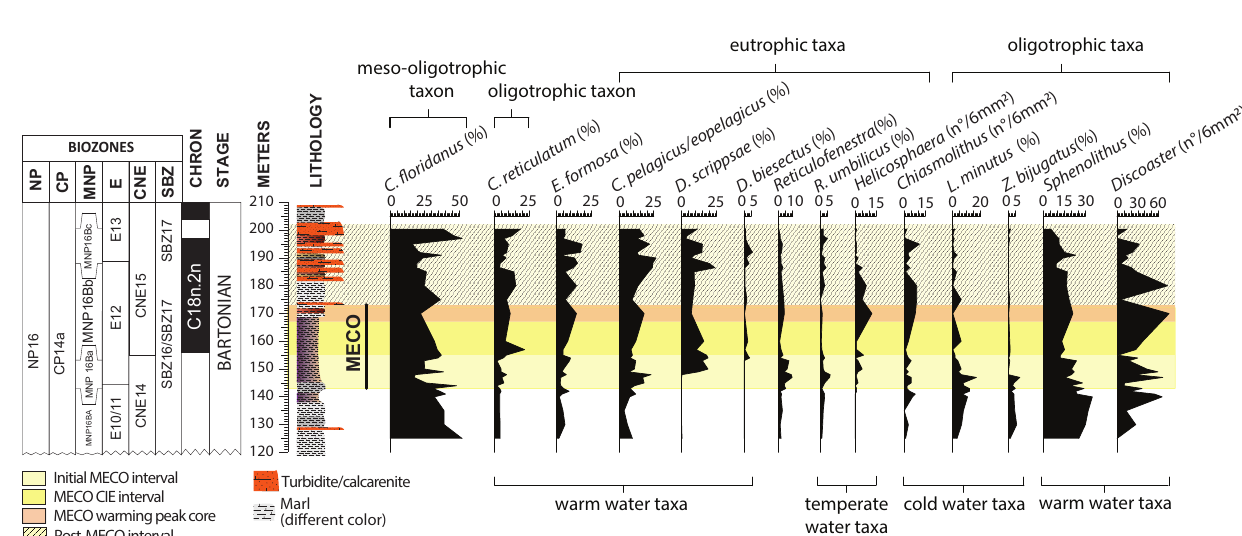
Figure 6. Abundances of middle Eocene planktic calcareous nannofossils genera and selected species from the Baskil section. The main ecological preferences are also indicated (see text for explanations). Magneto-biostratigraphy and lithostratigraphy as in Figure